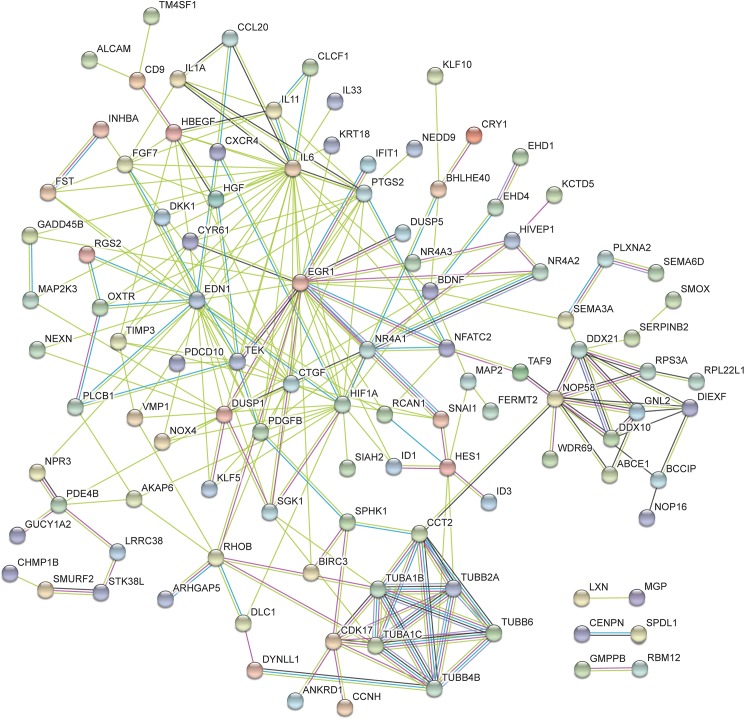
This network represents the differentially expressed genes regulated in thrombin transactivation of the EGFR.The functions of this network include biological processes, molecular functions and cellular component. The color of the nodes indicates the query protein and its first shell of interactions. Protein nodes which are enlarged indicates the availability of 3D protein structure information. The colored lines between the nodes indicated the query protein-protein interactions. The known interactions is a light blue (from curated database) or pink (experimentally determined) lines between the proteins. The predicted interactions use green (gene neighborhood), red (gene fusion) and dark blue (gene co-occurrence) lines. The yellow represents text mining, the black represent co-expression and the purple lines represent protein homology.